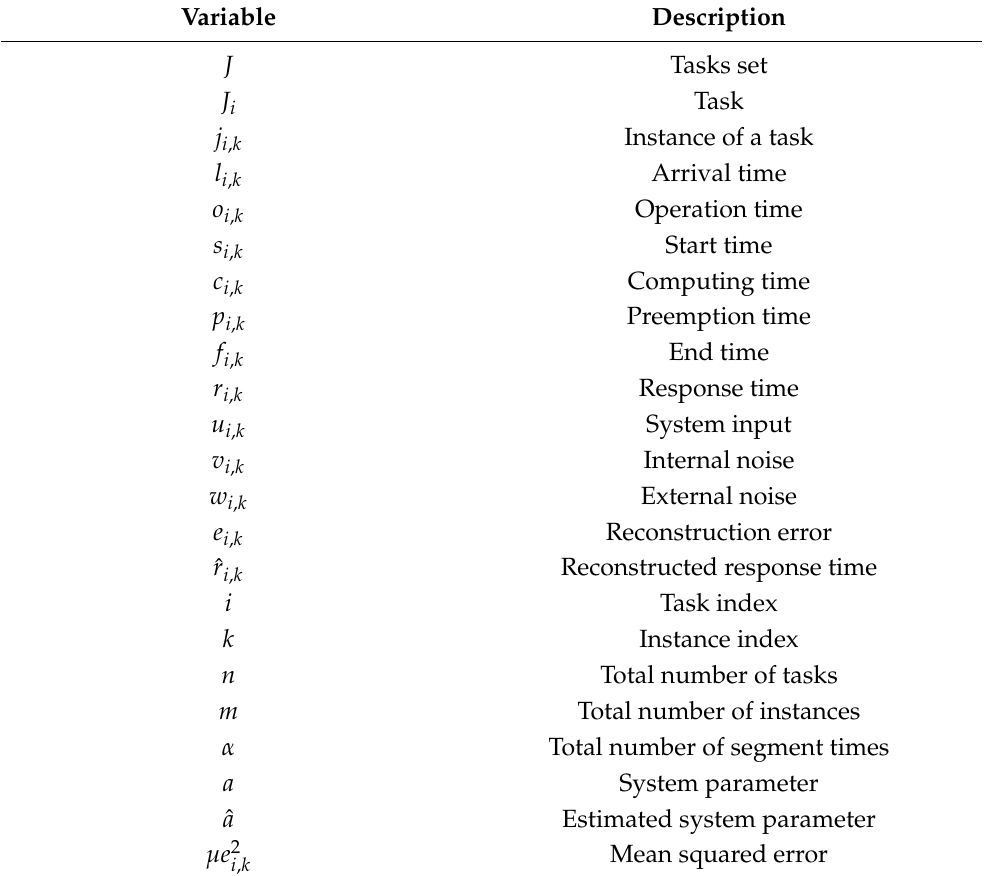
Table 1. List of